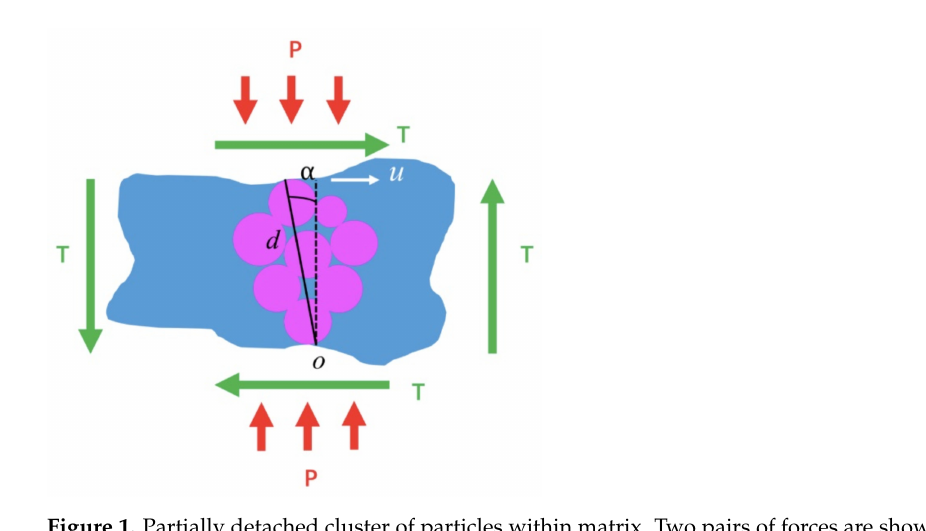
Figure 1. Partially detached cluster of particles within matrix. Two pairs of forces are shown in order to emphasise that moment equilibrium should hold.